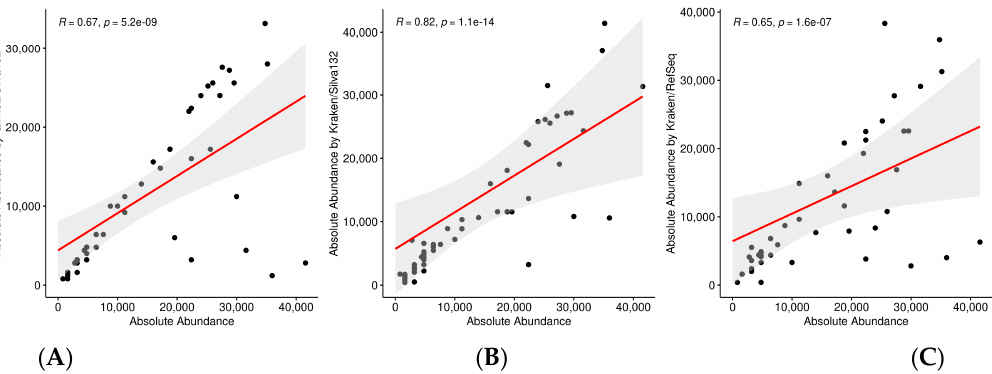
Figure 9. Correlation plots between the relative abundance of genus detected in Reference and QIIME2 or Kraken/Bracken pipeline with SILVA database and RefSeq repository . Each plot rep- resents the Spearman correlation between the relative abundance of gut species from Almeida and collaborators detected by QIIME2 ( A ), Kraken/Bracken pipeline with SILVA database ( B ) and Kraken/Bracken pipeline with RefSeq repository ( C ) with its own value of correlation coefficient.